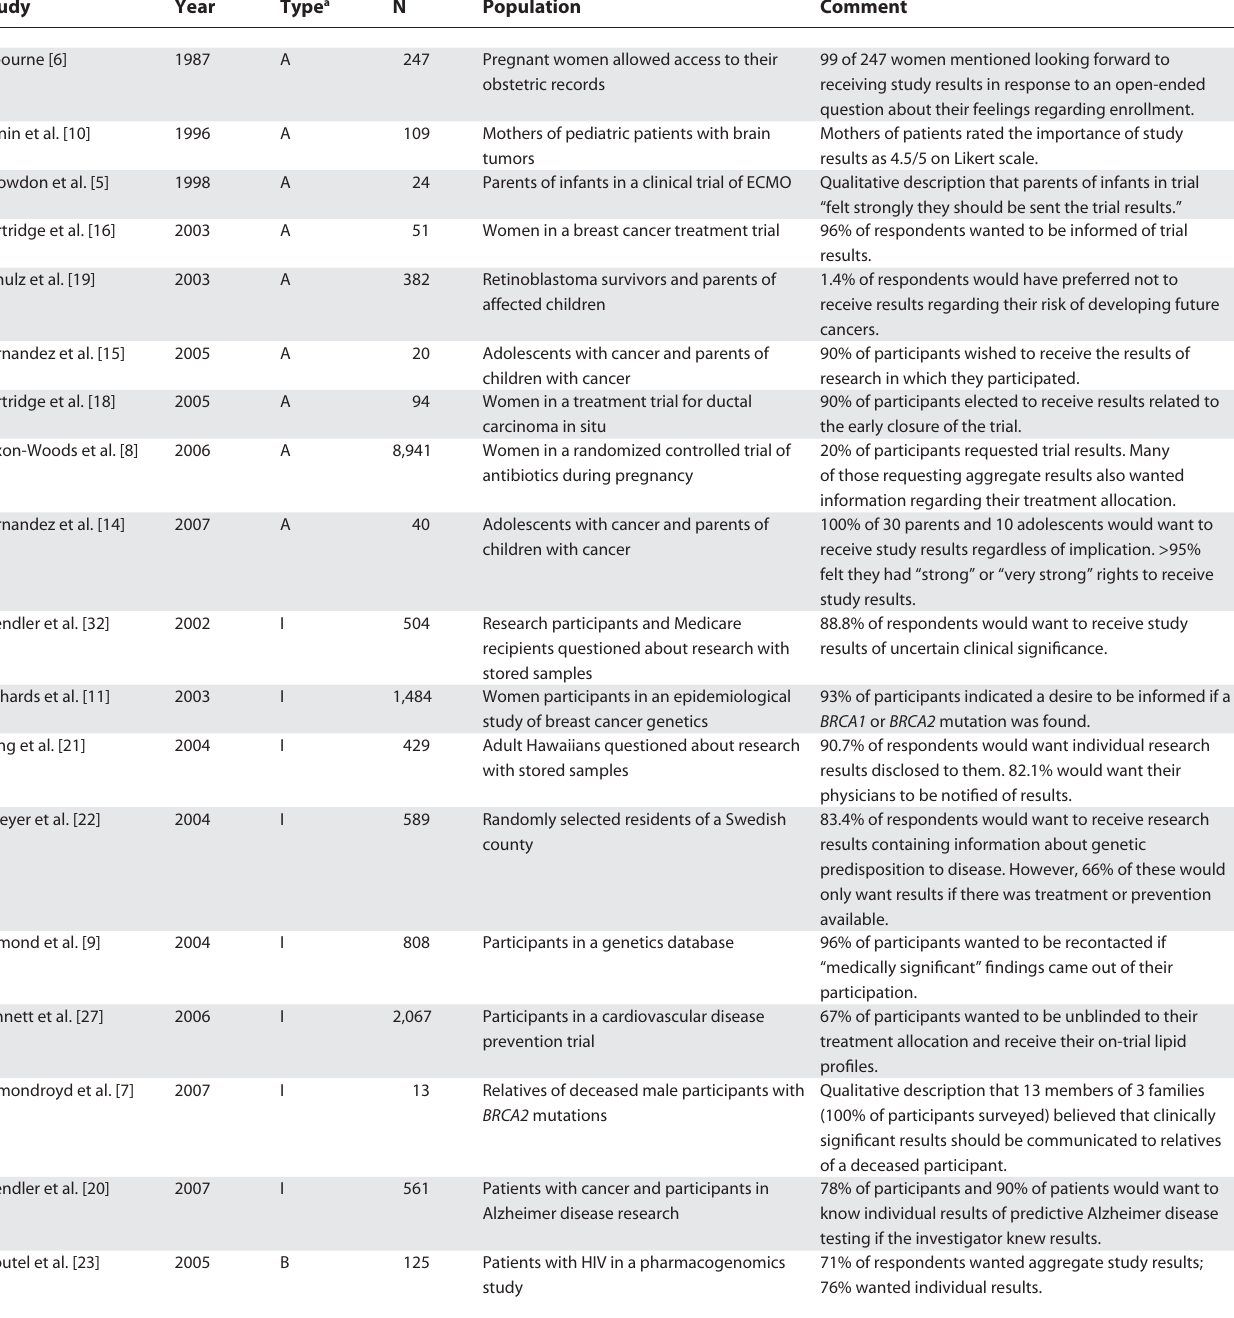
Table 1. Participant Desire for Study